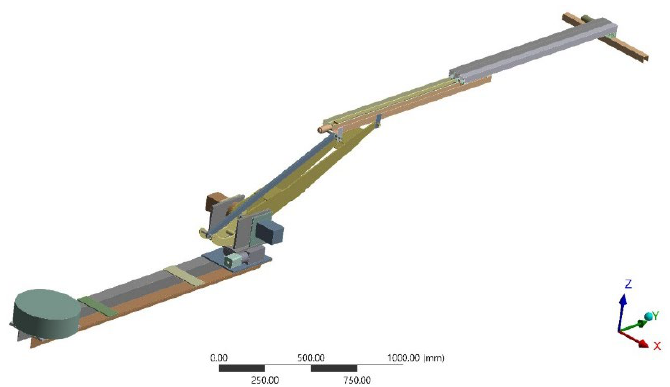
Figure 23. CAD Model for modified FEA setup for the fully-extended manipulator.